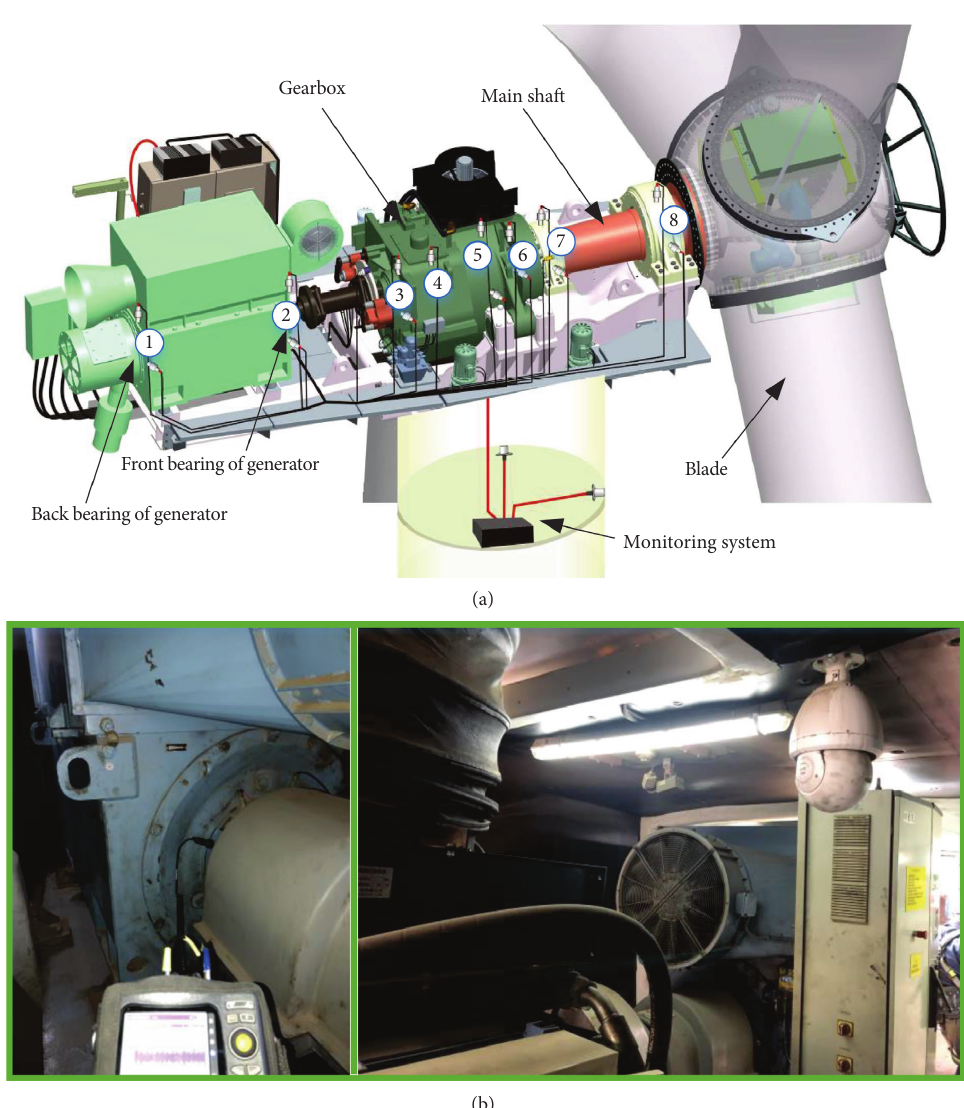
Figure 17: (a) Diagram of experimental device and distribution of measuring points. (b) Data collection on field wind turbine